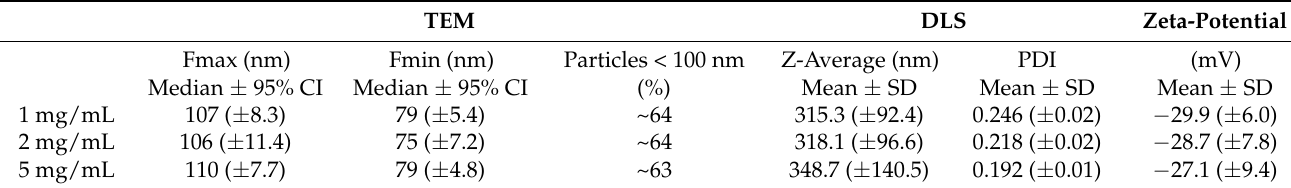
Table 1. Summary of particle characterization of food-grade E171 dispersed in sterile water. Particle